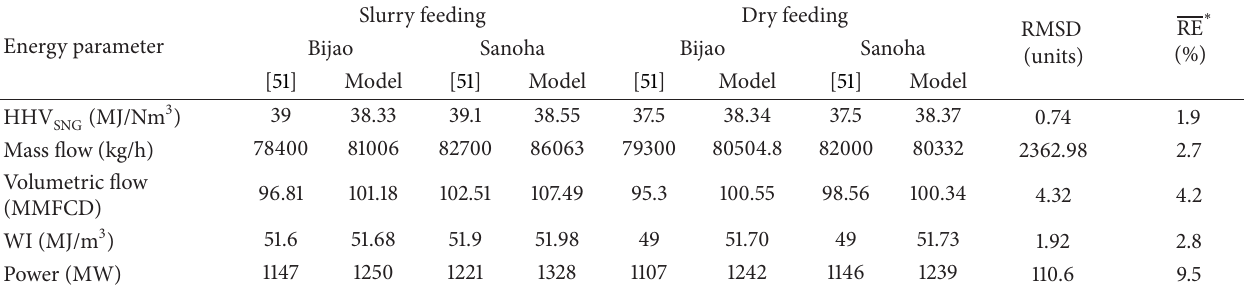
Table 7: Model validation with regard to SNG production and quality as gaseous fuel.